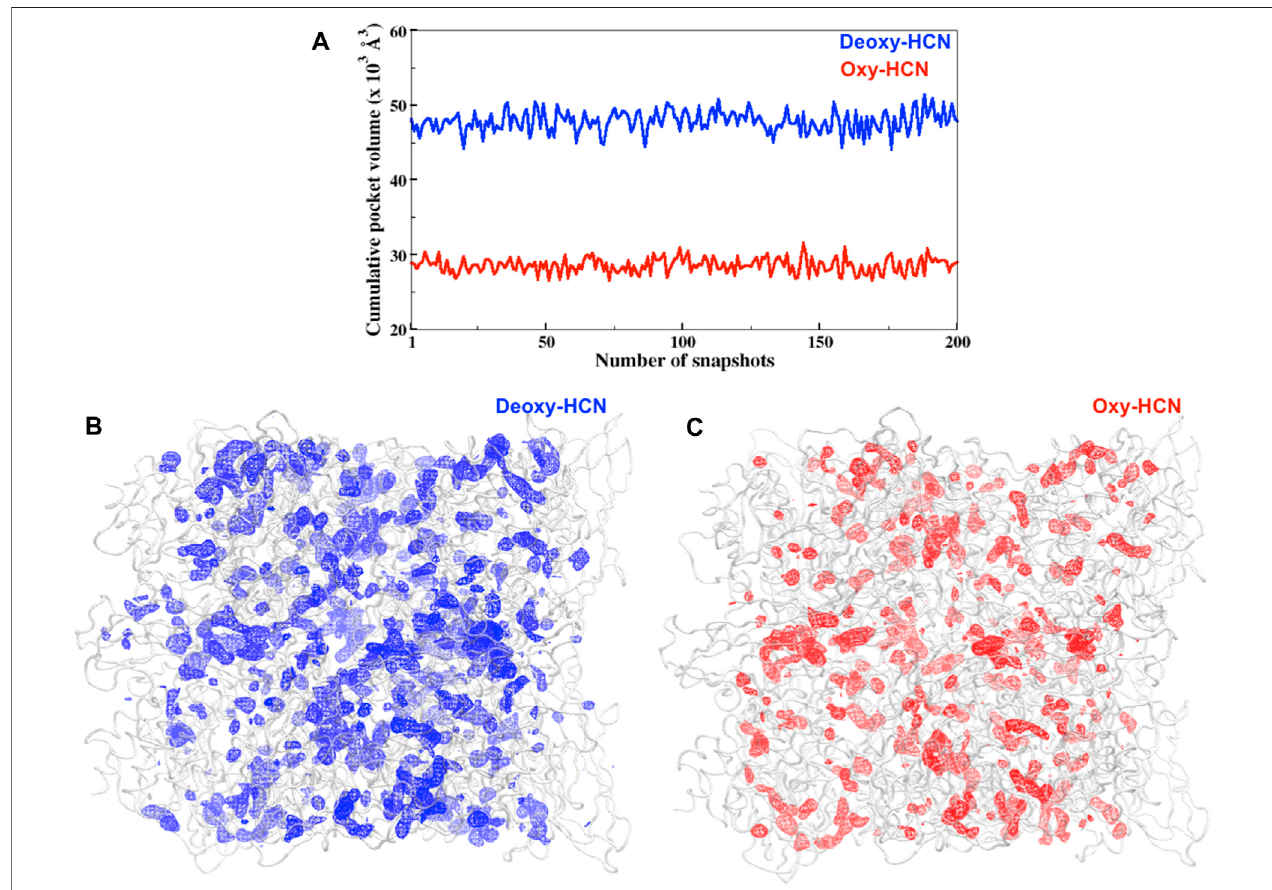
FIGURE8|(A) CumulativepocketvolumesofcavitiesfacilitatingthepassageofoxygenwithinsubunitsforDeoxy-HCN(blue)andOxy-HCN(red).Thevolumewas calculated from 200 snapshots of each system, which was extracted from the last 40 ns of each trajectory (B) Three-dimensional depiction of cavity density (mesh) spread in the (B) Deoxy-HCN (blue) and (C) Oxy-HCN (red) hexamers. The lower cumulative pocket volume Oxy-HCN (red) indicates a more stable closed state in Oxy-HCN.